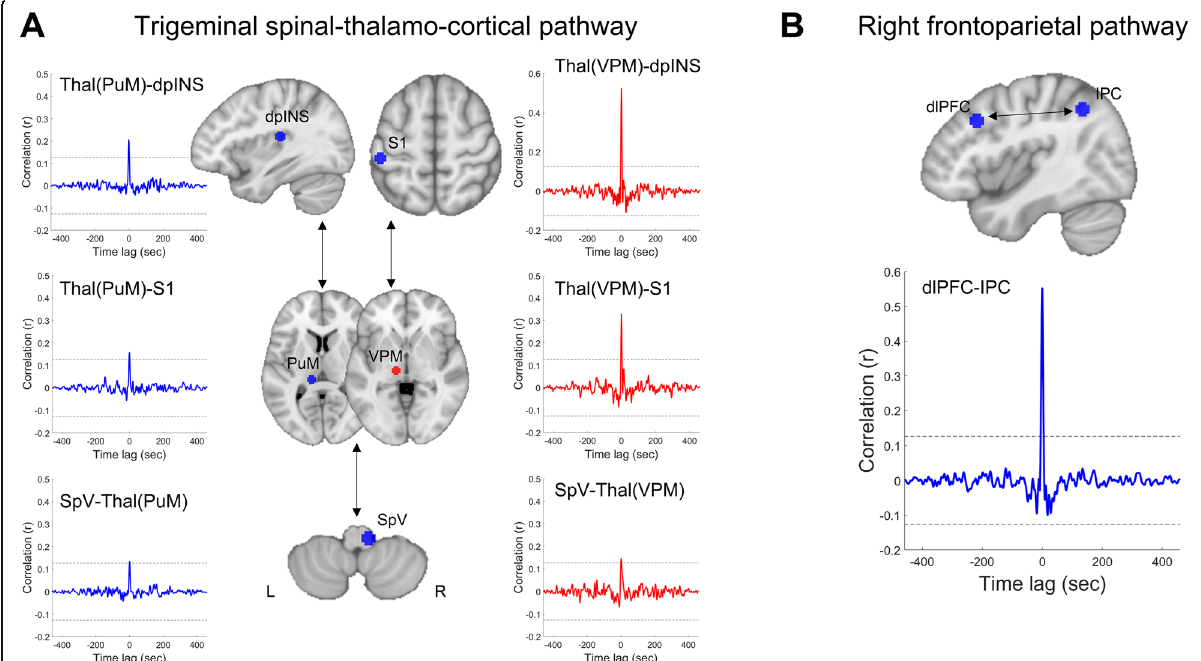
Fig. 3 Cross-correlation of the resting-state BOLD signal time course. Cross-correlation of the BOLD signal within the trigeminal spinal-thalamo- cortical pathway ( a ), which was increased BOLD SV and right frontoparietal region ( b ), which was decreased BOLD SV . Blue and red masks in the brain image indicate the locations of the maximum difference of BOLD SV within the frequency of 0.01 – 0.198 Hz except for S1, which was significant in the slow-4 (0.027 – 0.073 Hz) band. All time courses (0.01 – 0.198 Hz) were extracted from masks (5-mm sphere) to calculate cross- correlation between the regions. The blue and red lines indicate grand averaged cross-correlation across all 46 subjects. The upper and lower horizontal dotted lines indicate the approximate 95% confidence